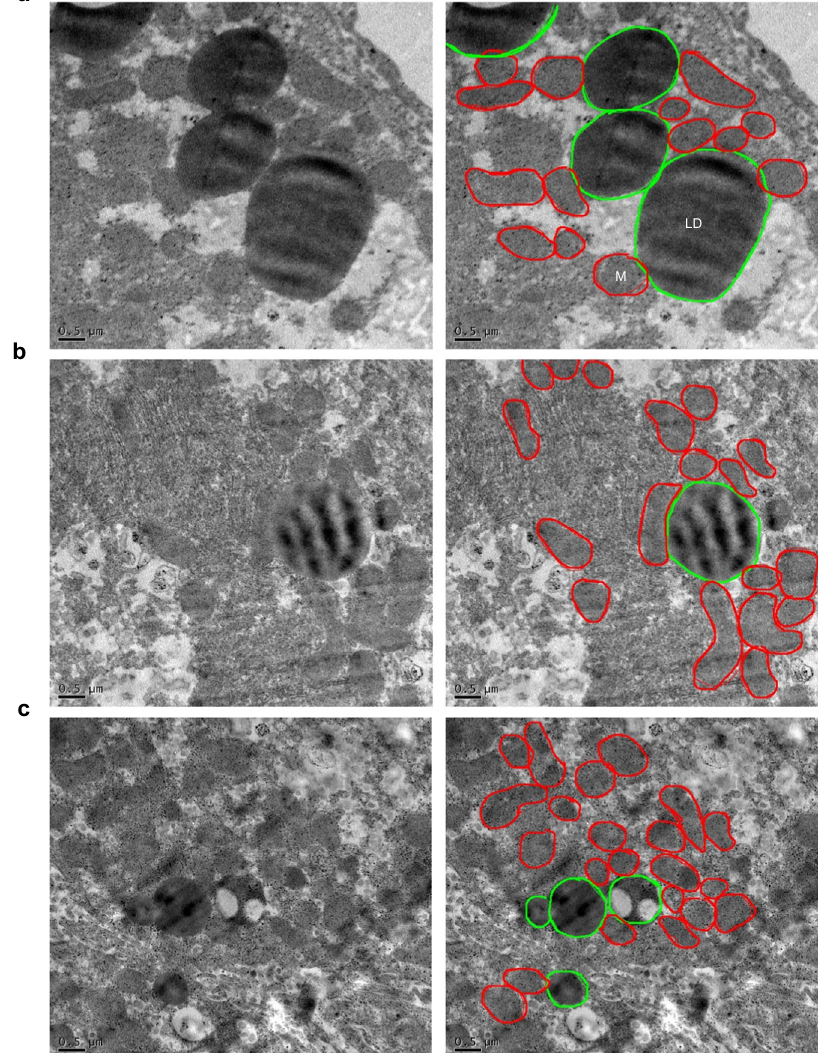
Fig. 1 | Transmission Electron Microscopy (TEM) images of Lipid Droplet associatedMitochondria(LDM)fromratliver. RepresentativeTEMimagesofrat liverharvested from adultWistarrats( a – c ; n =3)maintainedatroomtemperature